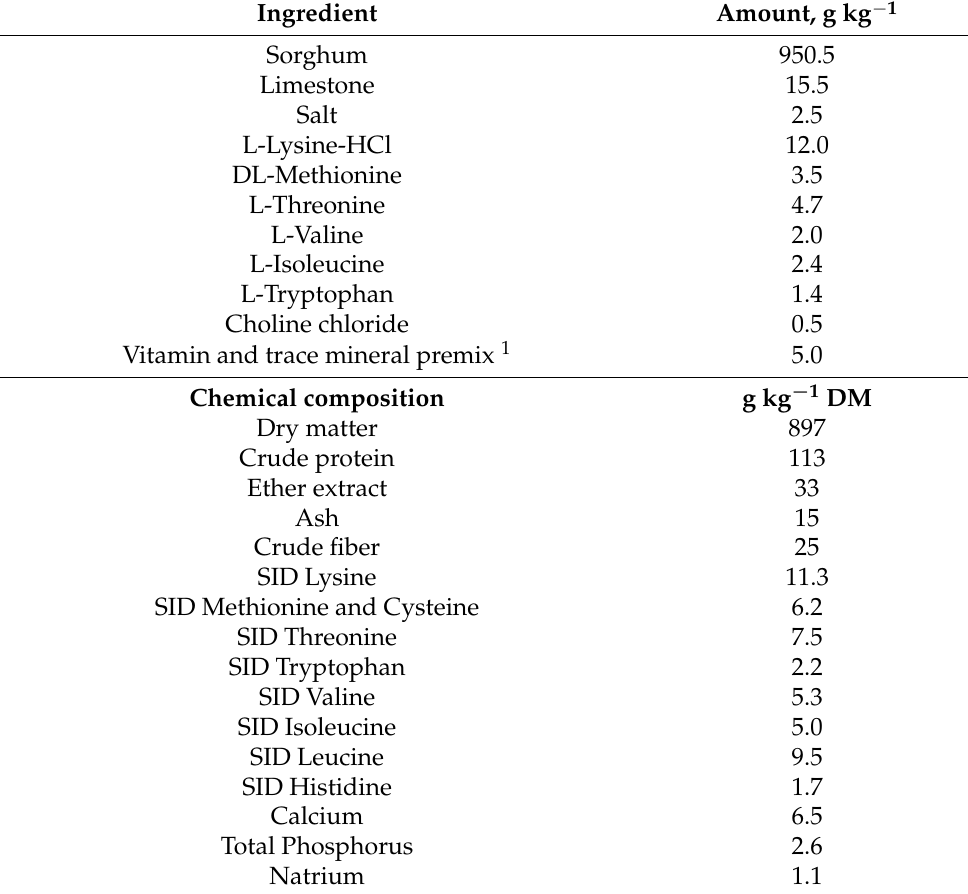
Table 1. Composition and calculated nutrients of test